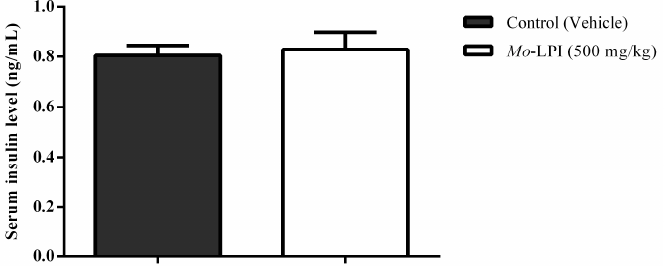
Figure 8. Effect of Mo -LPI on serum insulin level in alloxan-induced diabetic mice. Values are means ± S.E.M. ( n = 10). Five hours after Mo -LPI or 0.15 M NaCl i.p. administration in alloxan-diabetic mice, blood samples were collected via cardiac puncture to assay the insulin level. Control: vehicle (0.05 M Tris-HCl, pH 7.5, containing 0.15 M NaCl).